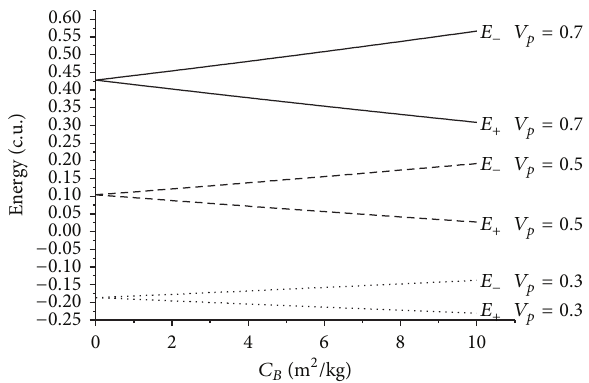
Figure 2: Evolution of the energies as a function of the ballistic coefficients for 𝜓 = 0 ∘ .